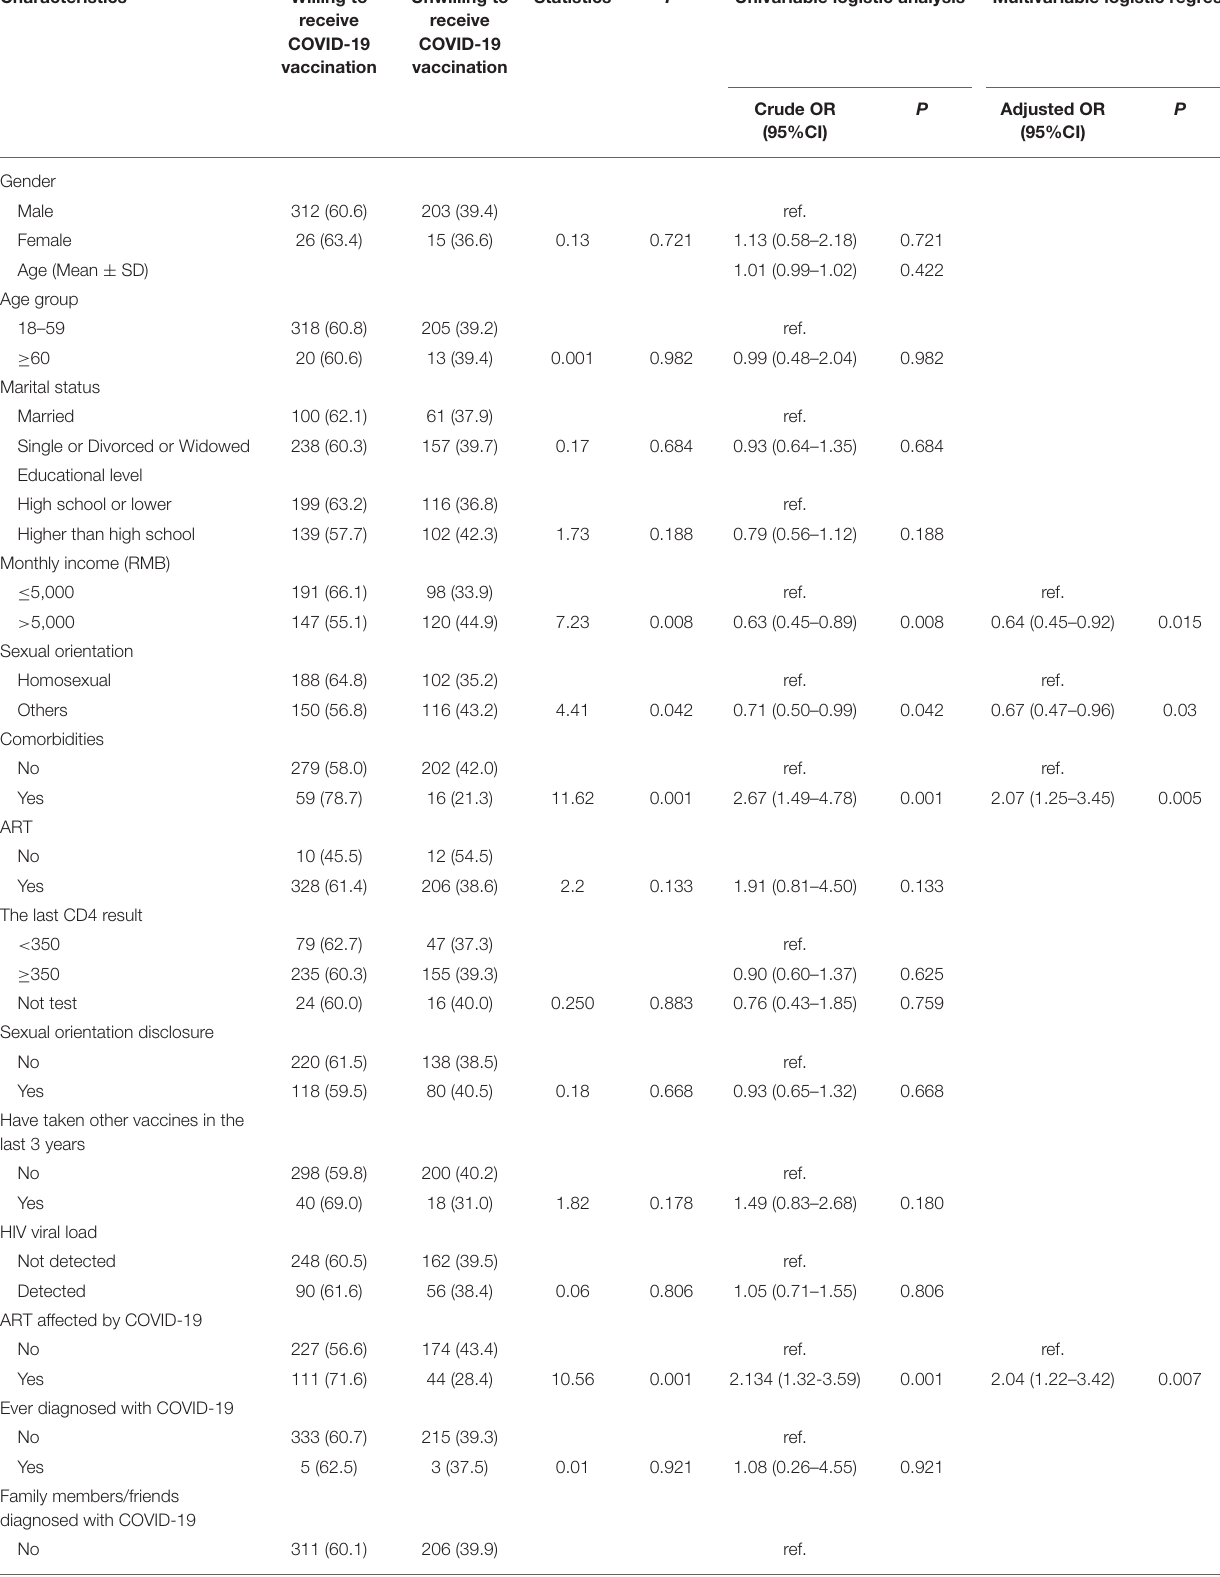
TABLE 2 | Univariate analysis and multivariable logistic regression on factors associated with COVID-19 vaccination willingness among PLWH in Wuhan, China ( N = 556).